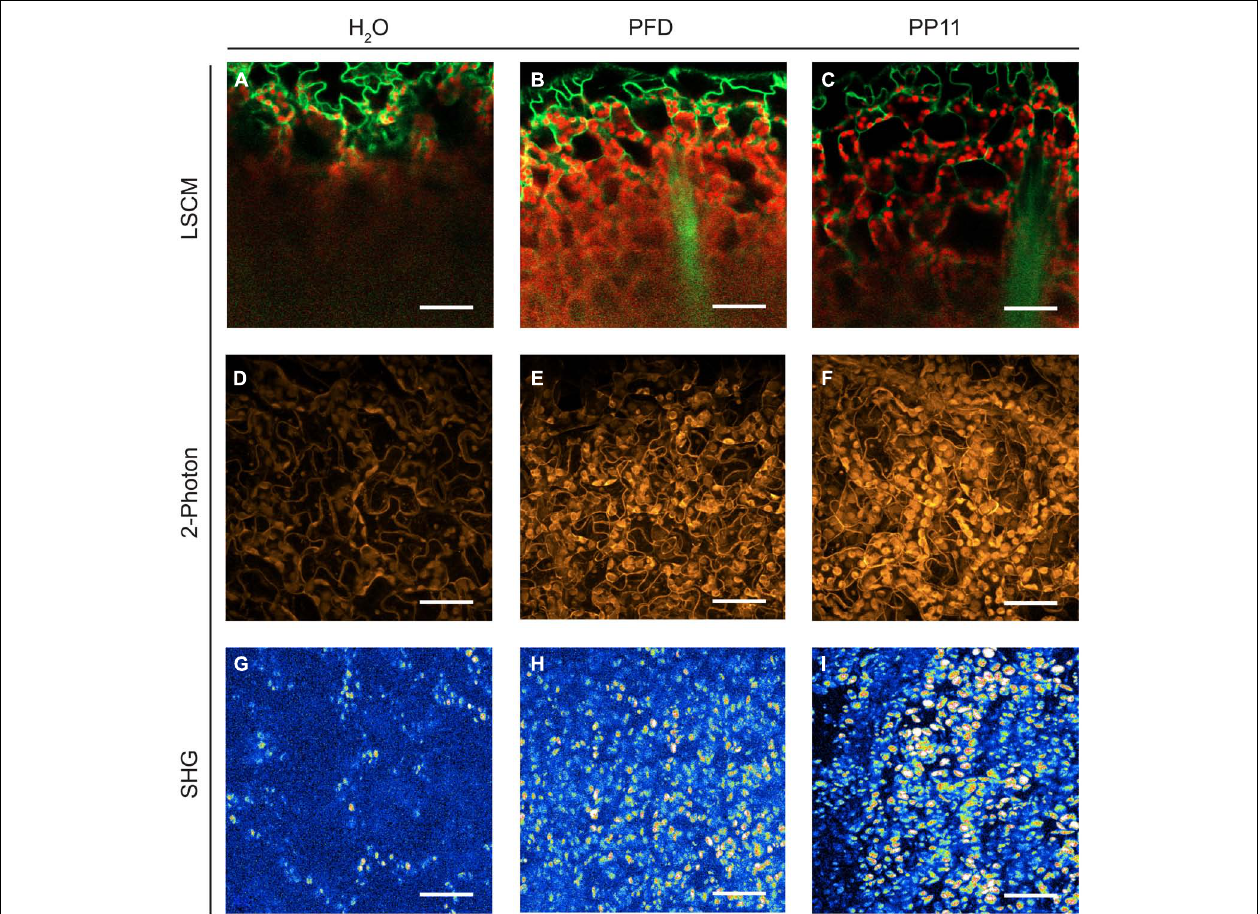
progression through the stack from top to bottom. Signal was collected from 518 to 604 nm forVenus, and is displayed in green and at 647–690 nm for chlorophyll, shown in red. (D–F) 2-photon micrographs taken of samples mounted in H 2 O, PFD, and PP11 respectively. (G–I) SHG micrographs taken of samples mounted in H 2 O, PFD, and PP11 respectively. (D–I) are presented as projections of z-stacks. Scale bars are 50 μ